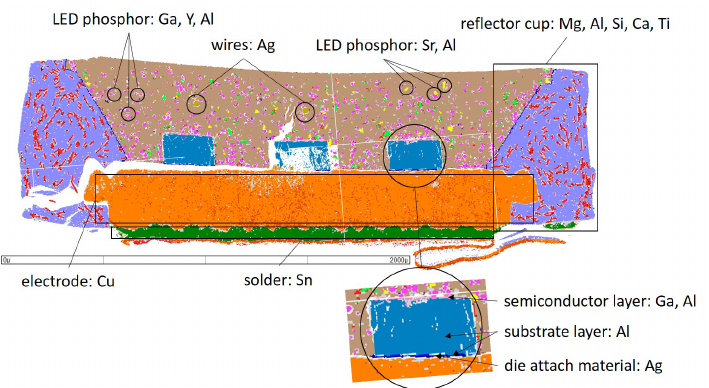
Figure 3. The profile of the LED package as determined by mineral liberation analysis (MLA). Table 2. Characterized LED modules and elemental composition of LED chips and